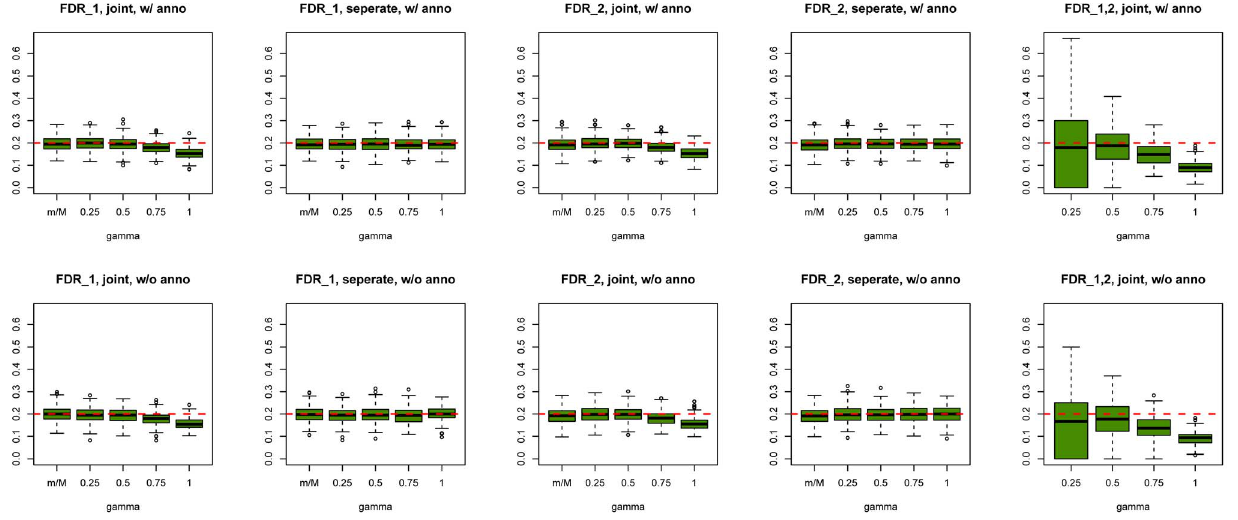
Figure 2. Global false discovery rates of GPA at sample size N =5000 and number of risk SNPs m =1000. Upper panel: Global false discovery rates of GPA with annotation. Lower panel: Global false discovery rates of GPA without annotation. From left to right: FDR of first GWAS (joint analysis), FDR of second GWAS (joint analysis), FDR of first GWAS (separate analysis), FDR of second GWAS (separate analysis) and FDR of risk variants shared by both GWAS. For all scenarios, the global false discovery rates of GPA are controlled at the nominal